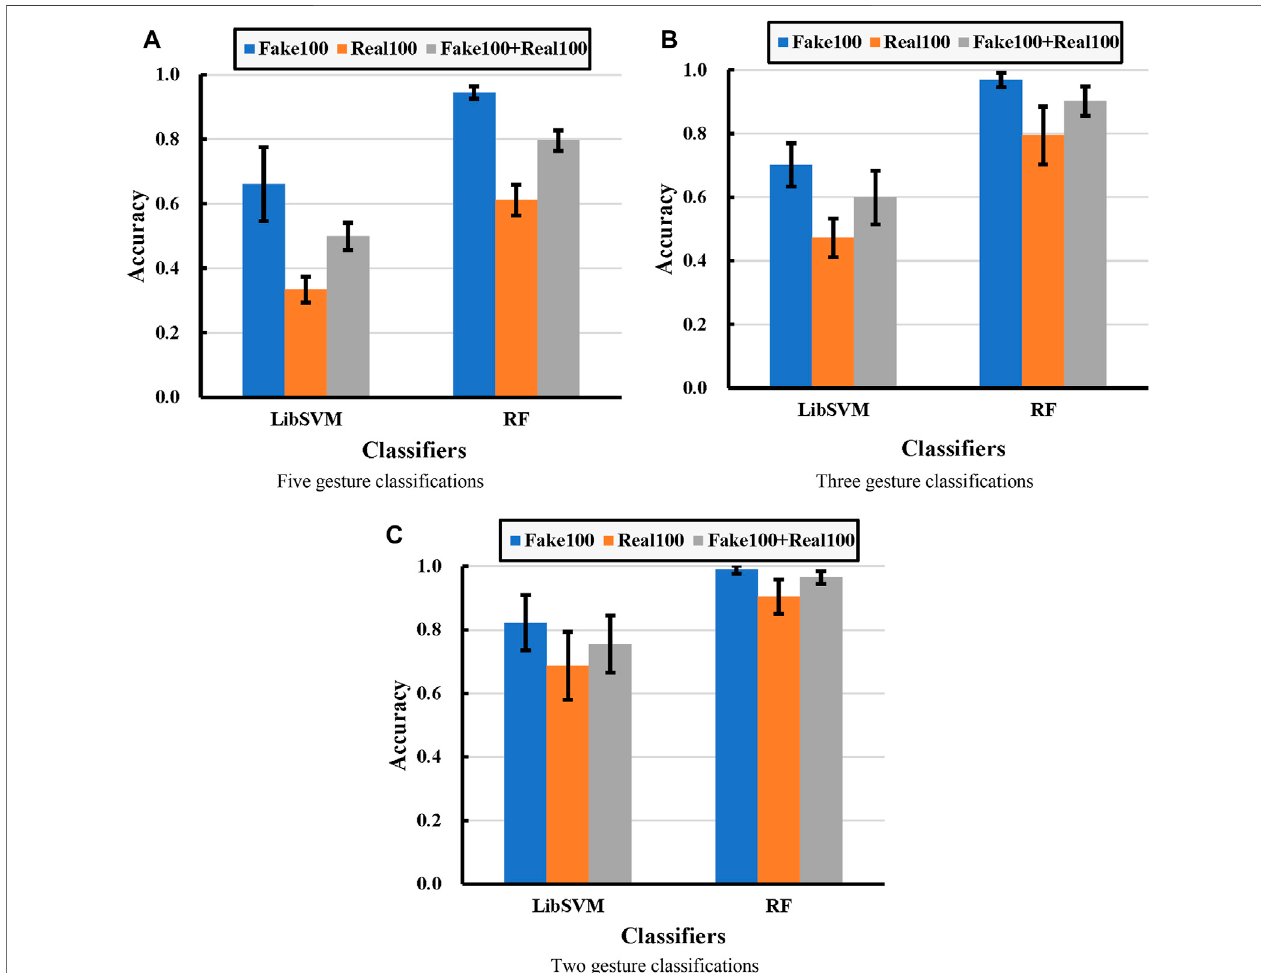
FIGURE 7 | Experimental comparisons under different classi fi cations, in which (A) , (B) , and (C) correspond to fi ve-, three-, and two-class classi fi cation problems, respectively. Each bar represents the classi fi cation accuracy, and the error bar represents the corresponding standard deviation. Real100 means cross-validation with 100realimages foreach gesture.Fake 100represents cross-validationwith100fakeimages foreach gesture. Fake100+Real100meanscross-validation with100fake images and 100 real images mixed for each gesture.